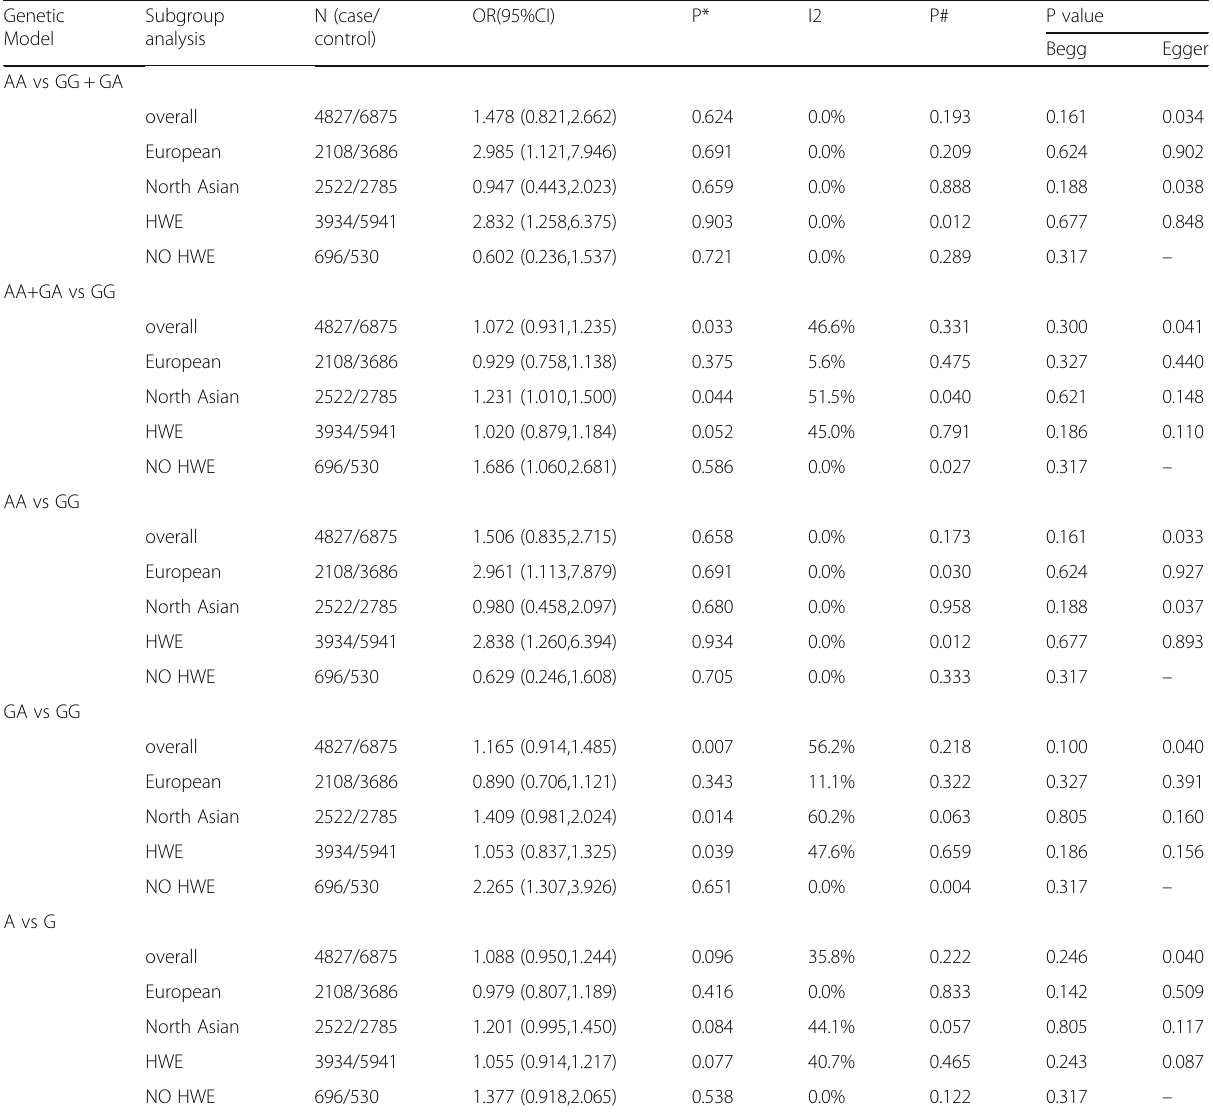
Table 3 Meta-analysis of TNF- α 238G/A polymorphisms and CAD susceptibility Genetic